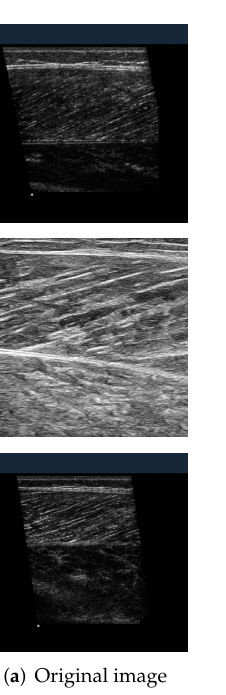
Figure 9. Comparison of visual segmentation results of different models. The boxes in white show the difference of segmentation results. The red area of the segmentation result represents aponeuroses, the blue area represents muscle fibers, and the green area represents the background. ( a ) Original images. ( b – e ) Segmentation results of different models. The aponeuroses and muscle fibers of the proposed model are closer to the ground truth.